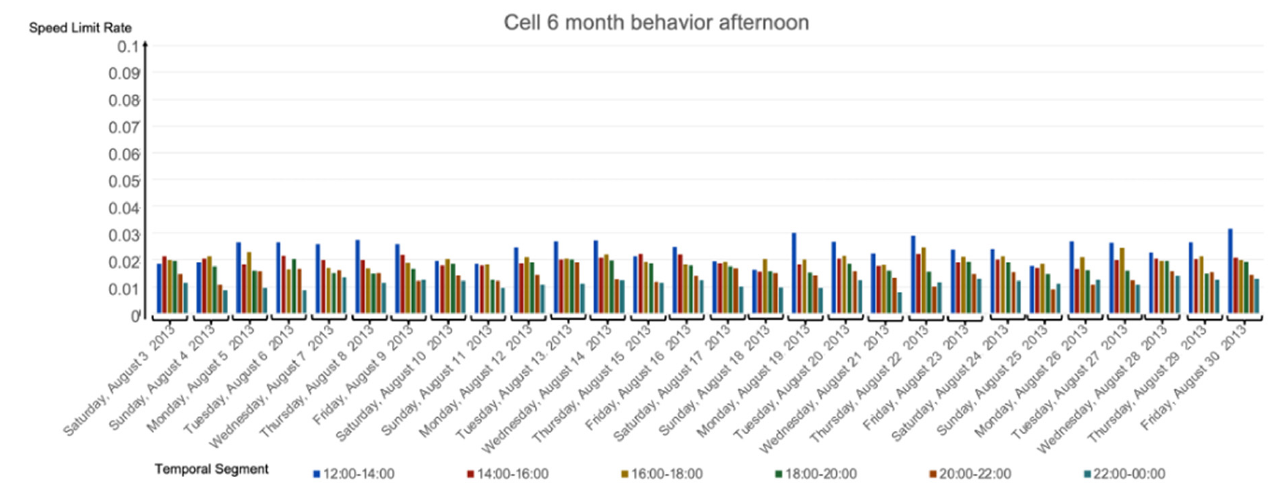
Figure A5. Results for the 28 days, cell 6 with MaxSpeed = 10 km/h in the morning.